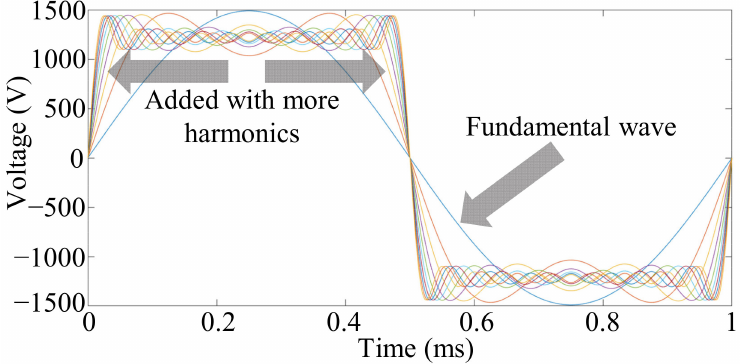
Figure 4. Formation of the square